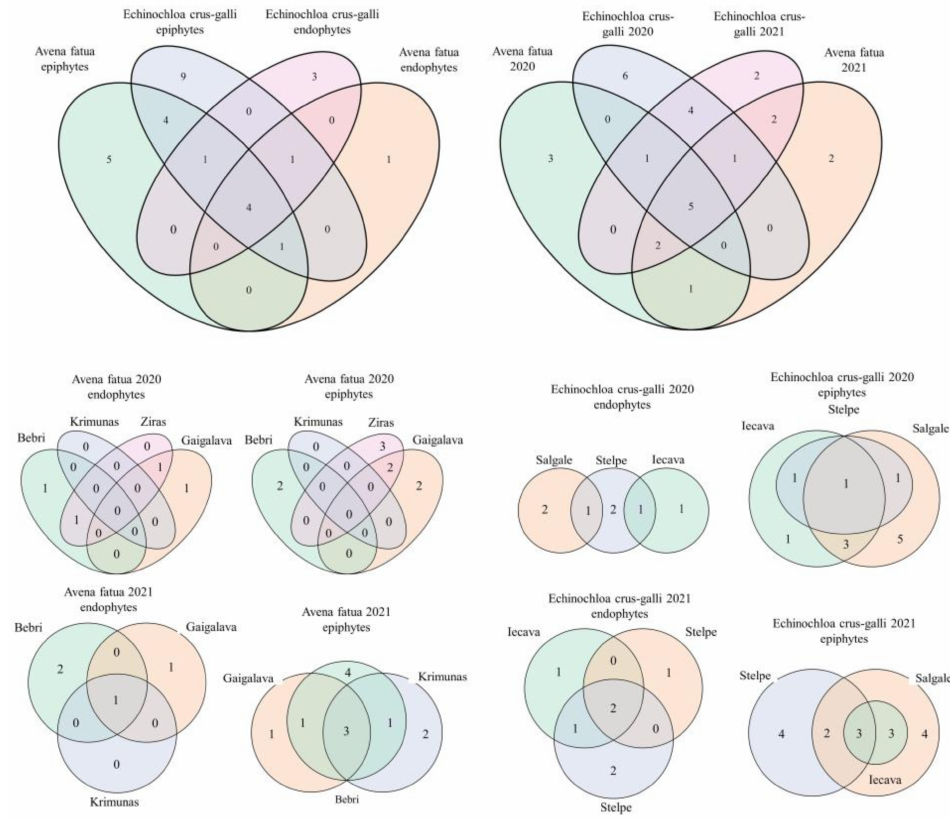
Figure 2. Venn diagrams showing the numbers of genera overlapping between different seed samples and habitats